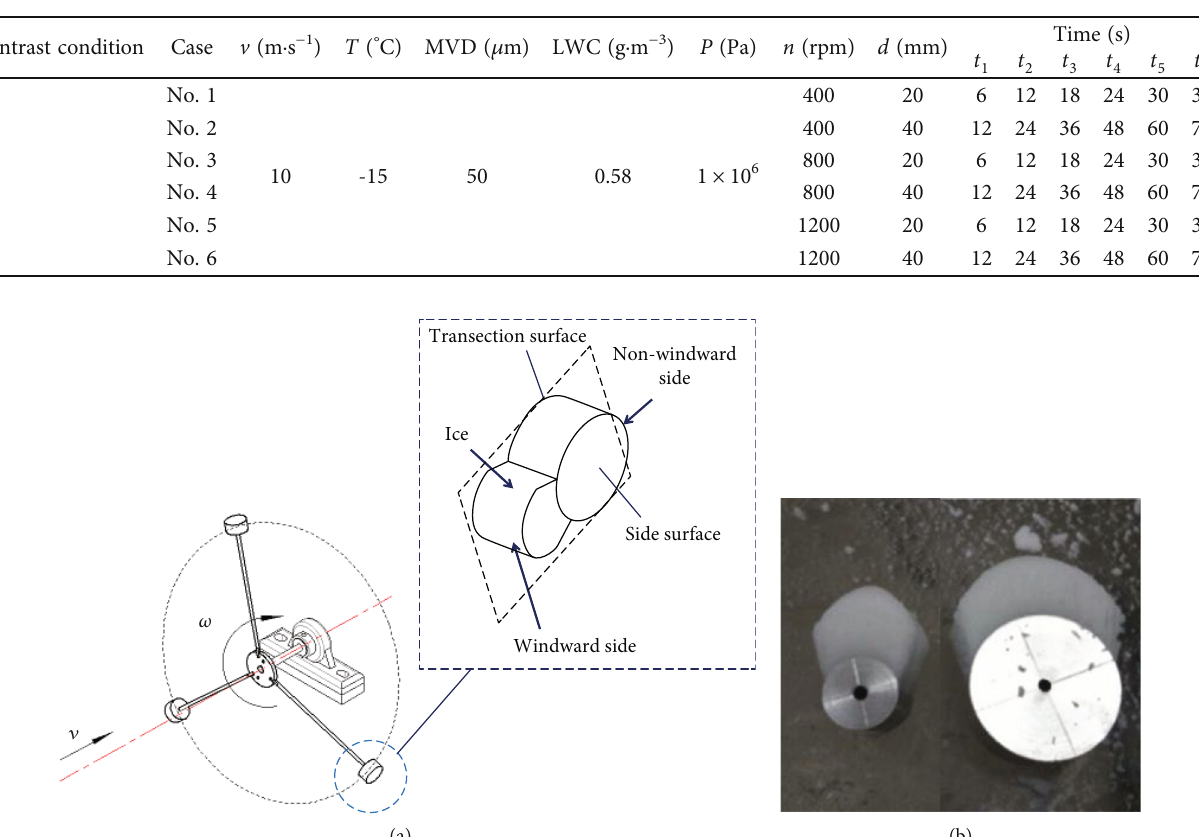
Table 1: Experimental scheme.